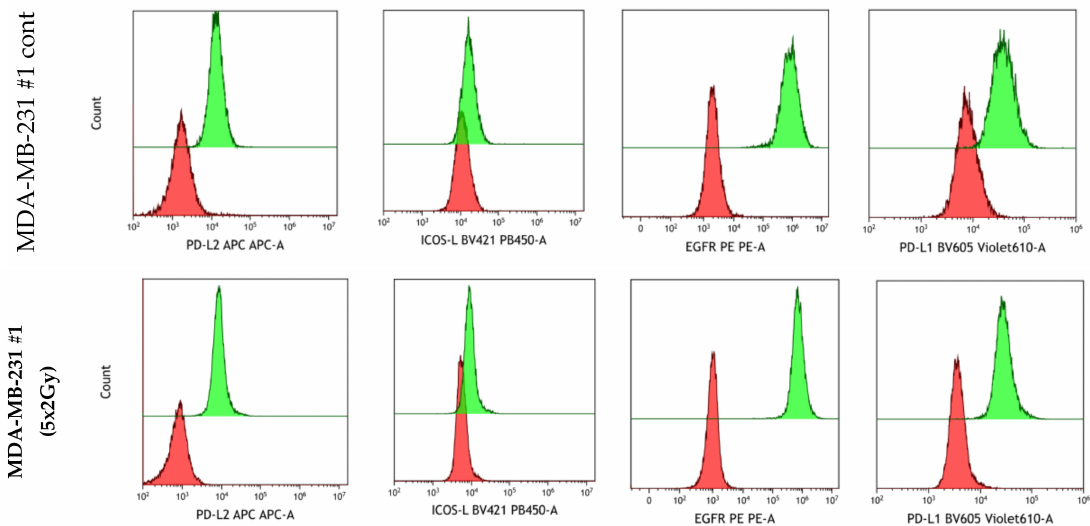
Figure A2. Fluorescence intensity (FI) peak of each fluorochrome of Panel#1 for untreated (cont., d5) and and irradiated (5 × 2 Gy, d5) MDA-MB-231 cells.